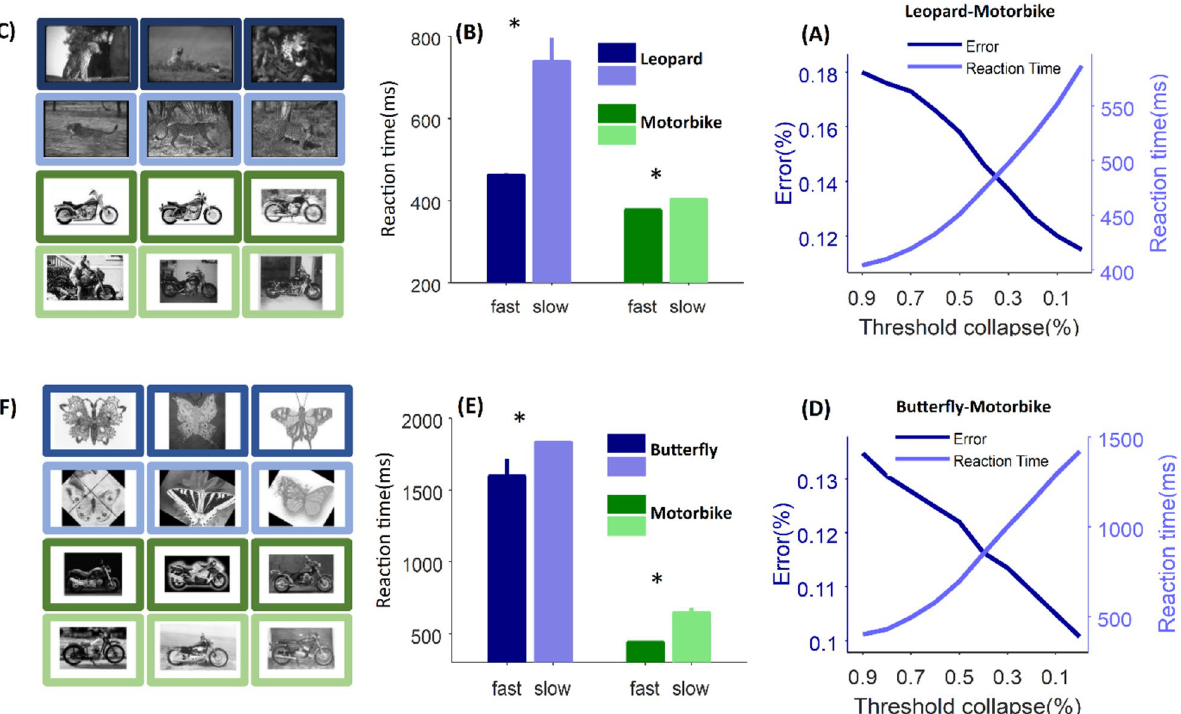
Figure 8. Model behavior on leopard-motorbike and butterfly-motorbike categorization. ( A ) Speed-accuracy trade off can be controlled by threshold on leopard-motorbike categorization. The X-axis indicates the percentage of collapse in the decision bound y axis shows error rate and reaction time of the model. ( B ) Average reaction time for the fast (dark colors) and the slow (bright colors) correct responses of leopard (blue) and motorbike (green) categories. Fast responses are 50% of trials which correctly touched the optimum threshold sooner and slow responses are the other half of trials which correctly touch the optimum threshold later. Here the optimum threshold is the threshold which minimize the error rate. ( C ) Samples of fast and slow responded images in both leopard and motorbike categories. Colors are consistent with those in the bar graph. ( D ), ( E ) and ( F ) are similar to ( A ), ( B ), ( C ) respectively but for the butterfly-motorbike